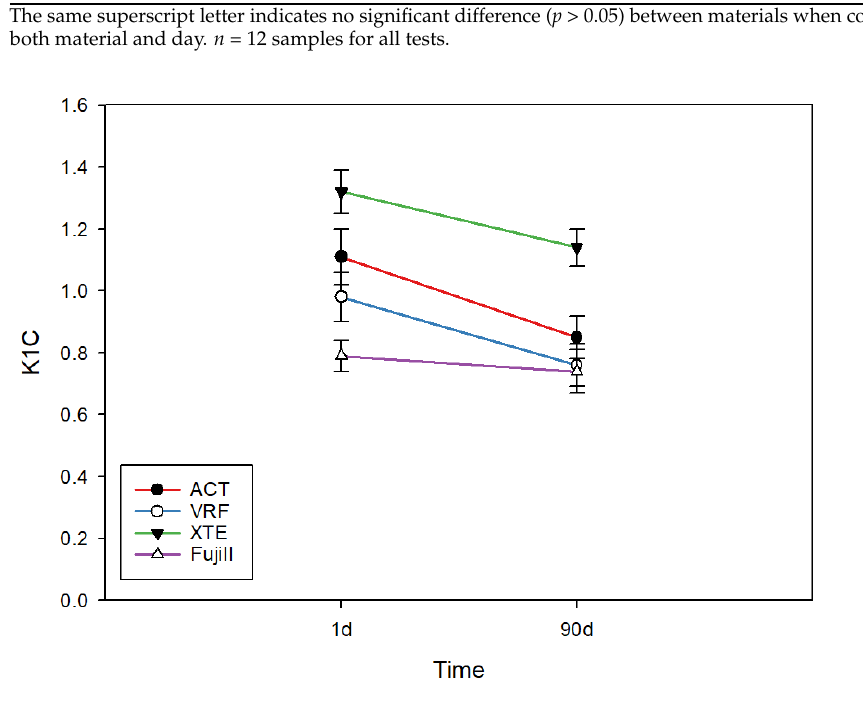
Figure 2. Fracture toughness of materials after 1 and 90 d of storage in water at 37 °C. n = 12 samples for all tests.